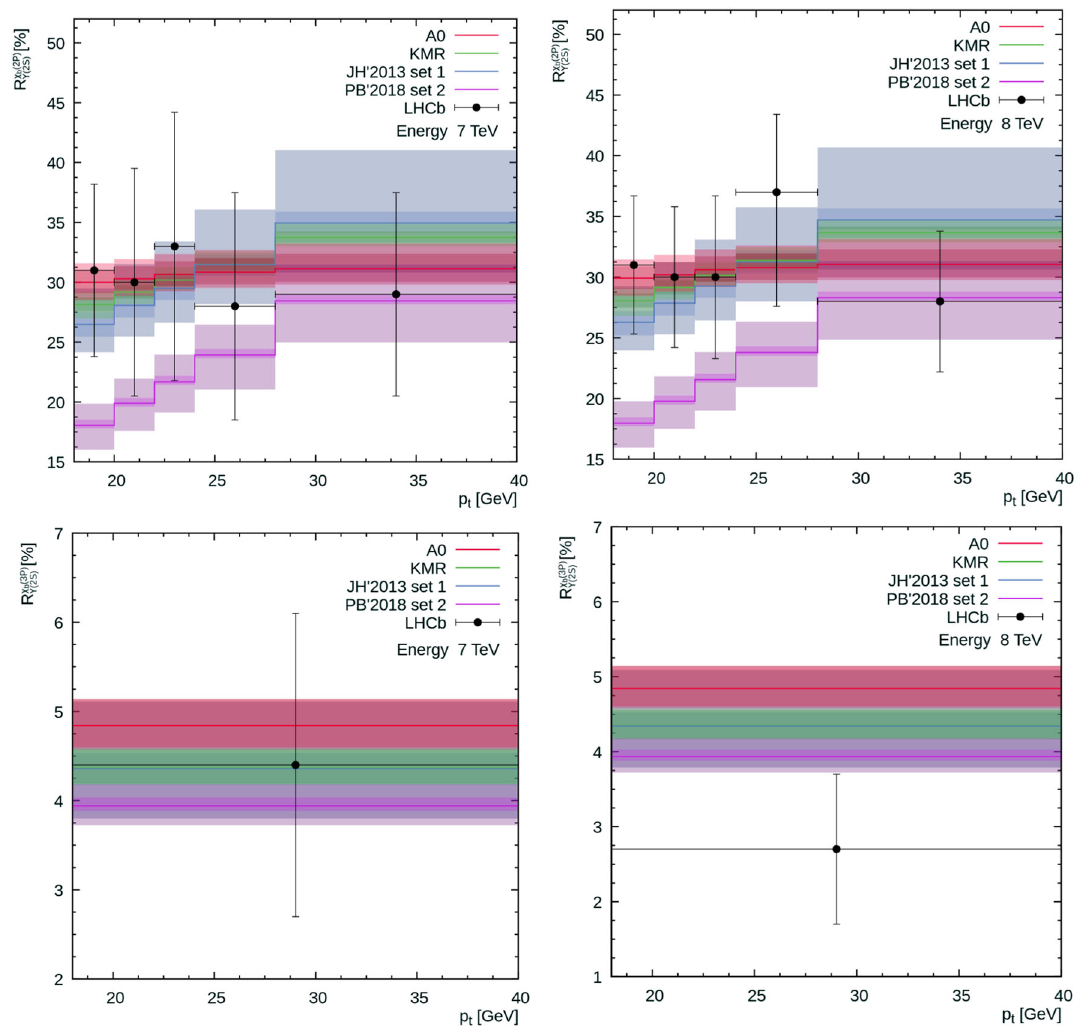
χ b ( mP ) ϒ( 2 S ) transversemomentum.NotationofallhistogramsisthesameasinFig.2.Theexperimental Fig. 4 Theratio R ϒ( 2 S ) calculatedasfunctionof data are from LHCb